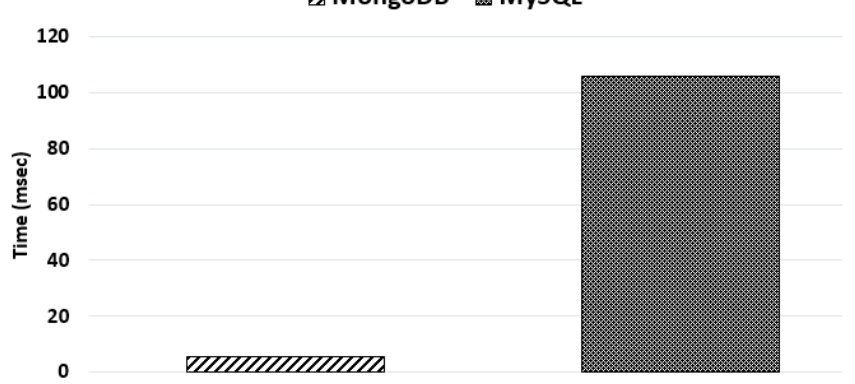
Figure 13. Insertion average time of documents and records respectively in MongoDB and